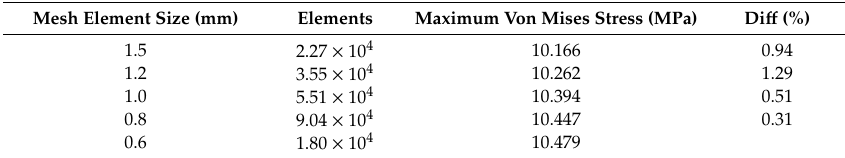
Figure 6. Mesh independence validation. Table 9. Mesh analysis information.